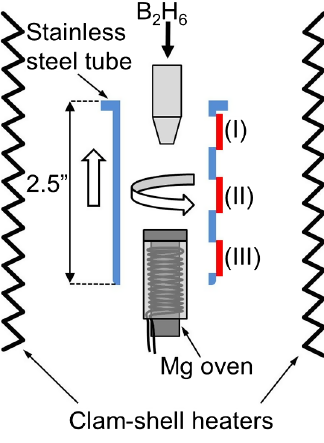
FIG. 3 (color online). Schematic view of the setup for stainless steel tube with samples mounted at the (I) top, (II) middle, and (III) bottom locations.